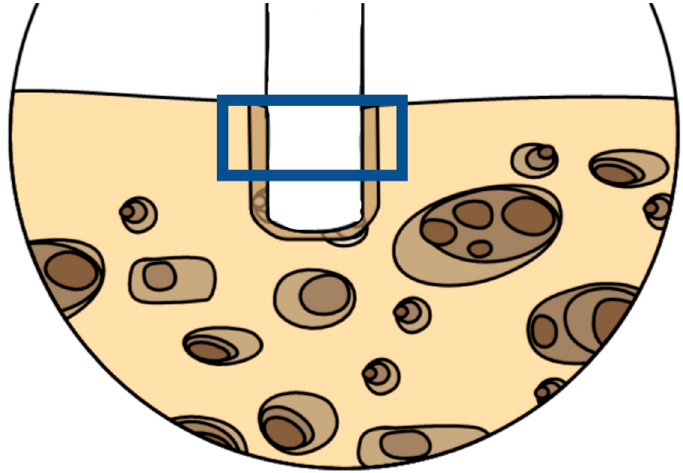
Figure 4. Representative scheme of the chosen area observed at the SEM-EDX to spot the metal particles debris. Picture realized using Mindthegraph ® infograph software (https://mindthegraph.com/ accessed on 10 February 2022).